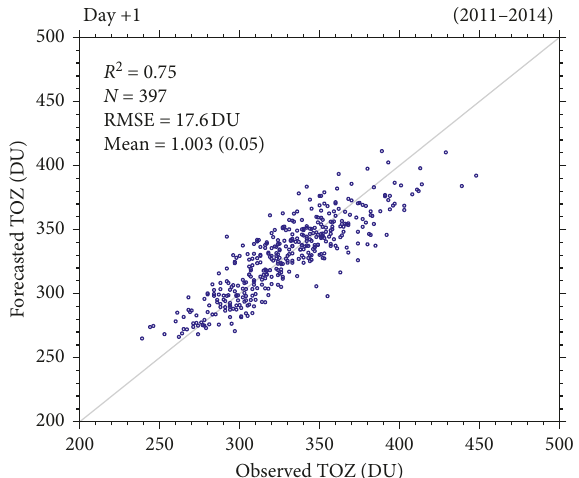
Figure 2: Relation between the observed and predicted total ozone amount for ( D +1)